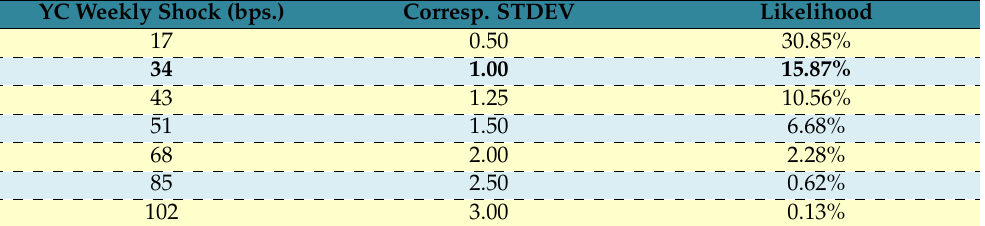
Table 7. Likelihood of principal components’ weekly yield curve shocks on 13 March 2020. YC Weekly Shock (bps.)